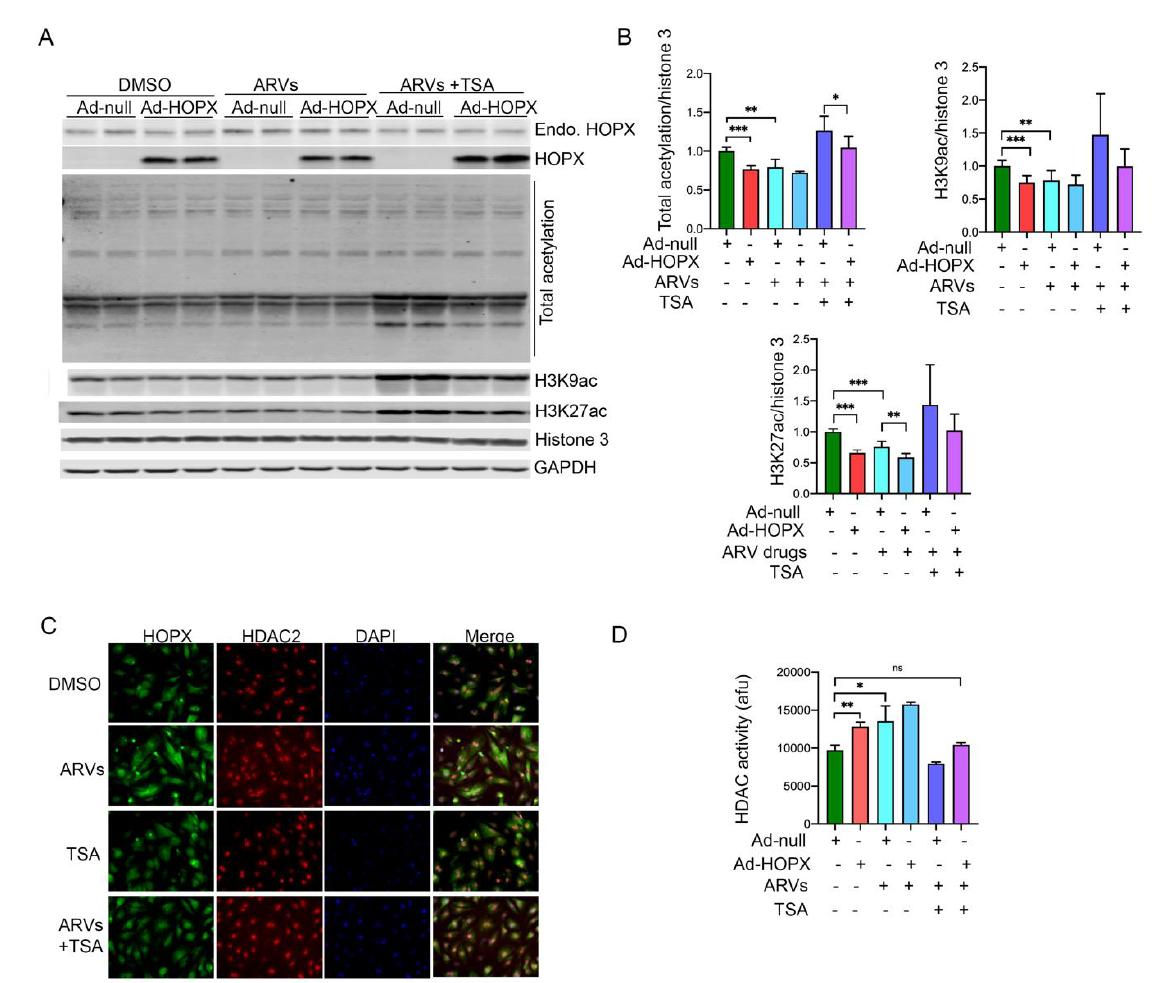
Figure 5. HOPX regulates ARV-mediated epigenetic modification of histone 3. ARV treatment in cardiomyocytes reduces total acetylated lysine level, as well as acetylation of histone 3 at K27 and K9. Cardiomyocytes were transduced with Ad-HOPX for 48 h and treated with ARVs, alone or in a combination with TSA (50 nM), for another 24 h. Control cells were transduced with Ad-null treated with ARVs or DMSO. ( A ) Western blot images show the expression of HOPX, total lysine acetylation, and acetylation at H3K9 and H3K27. ( B ) Graphs show quantification of Western blot images (*, p -value <0.05; **, <0.01; ***, <0.001). Values are presented as means ±SDs from three biological replicates and two technical replicates each time. ( C ) NRVCs were treated with ARVs or TSA for 24 h and fixed with 4% PFA. Cells were stained with HOPX and HDAC2 antibodies, and nuclei were counterstained with DAPI. Representative microscopic images of cardiomyocyte show localization of HOPX (Green), HDAC2 (Red), and nucleus (DAPI). ( D ) NRVCs were transduced with the Ad-HOPX or Ad-null and treated with the ARVs and TSA or DMSO. HDAC activity was determined using the protein lysate. Graph showing the deacetylase activity of HDAC. ( p -value, ns = not significant; *, <0.05; **, <0.01; ***, <0.001).